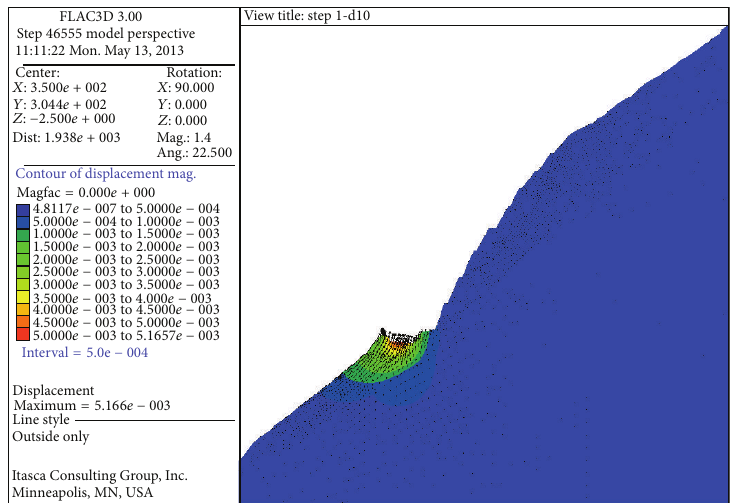
Figure 12: Displacement contour and displacement vector distribution after step 10 (unit: m).